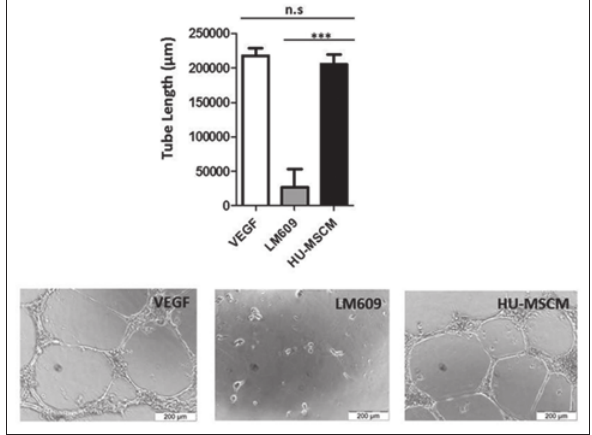
Figure-2: Human umbilical mesenchymal stem cells conditioned medium (HU-MSCM) promote angiogenesis. Vascular endothelial growth factor (VEGF) (white bar), monoclonal antibodies clone LM609 (gray bar), in concentration 40 μ g/ml and HU-MSCM (black bar) was added to endothelial cells, and tube formation was investigated by microscopy. Data are given as mean of tube length in μ m + standard deviation (upper panel). Statistical analysis was performed by one-way ANOVA followed by Bonferroni’s post-hoc test; n.s. = Not significant, VEGF = Control positive tube formation, LM609 = Control negative tube formation. Representative microphotographs of endothelial tube formation assays as outlined are given in the lower